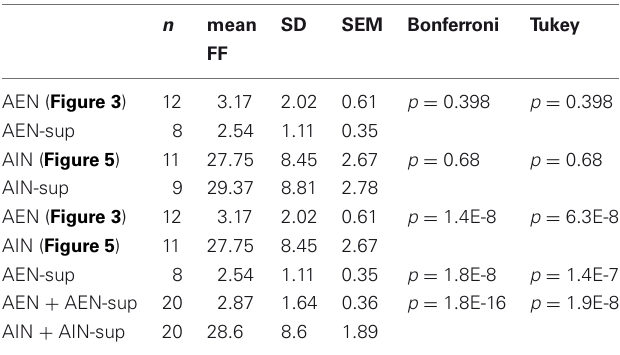
Table 1 | Statistical comparison of FF for AEN (Figure 3), AEN-sup, AIN (Figure 5), and